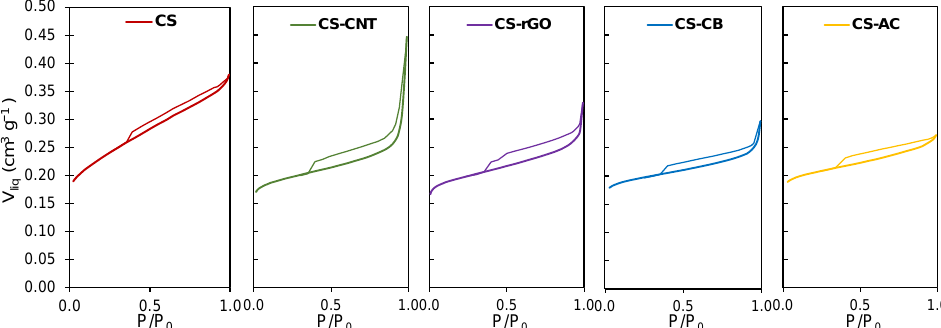
Figure 2. N 2 adsorption-isotherms obtained at −196 °C for pure glucose and glucose–carbon hybrids.